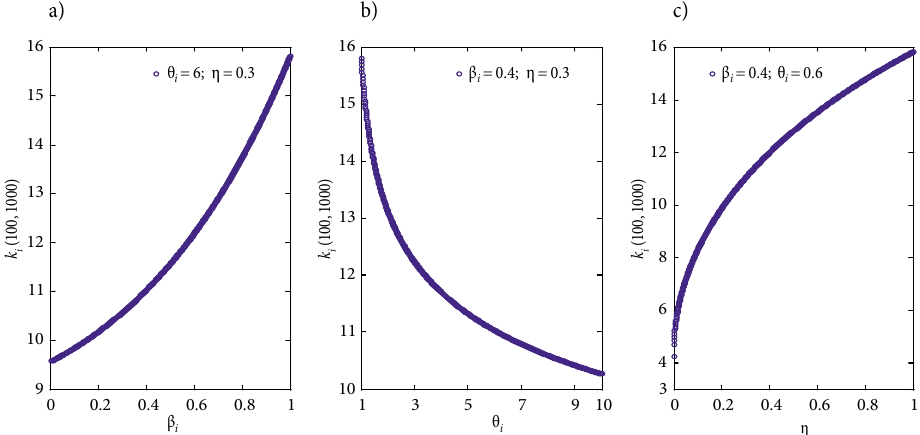
, the resistance q , and the average fitness h i i